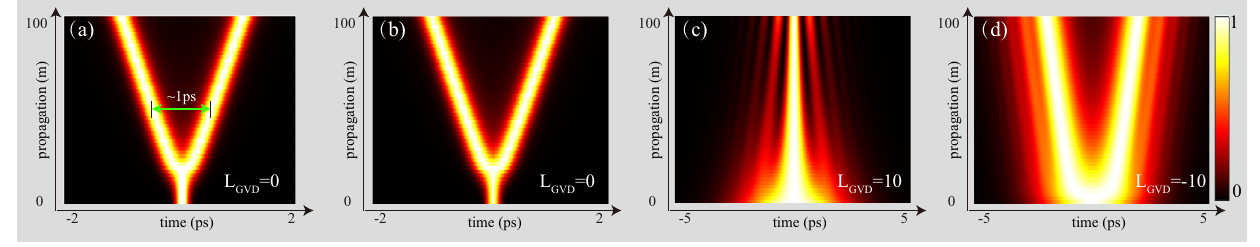
Fig. 6 | Simulations of the FSE with α =1. a The pulse dynamics, as produced by the analytical result (Eq. (18)). b The numerical simulation based on the Fourier transform. c , d The dynamics for L GVD =10 and − 10m, respectively ( L GVD =0 in